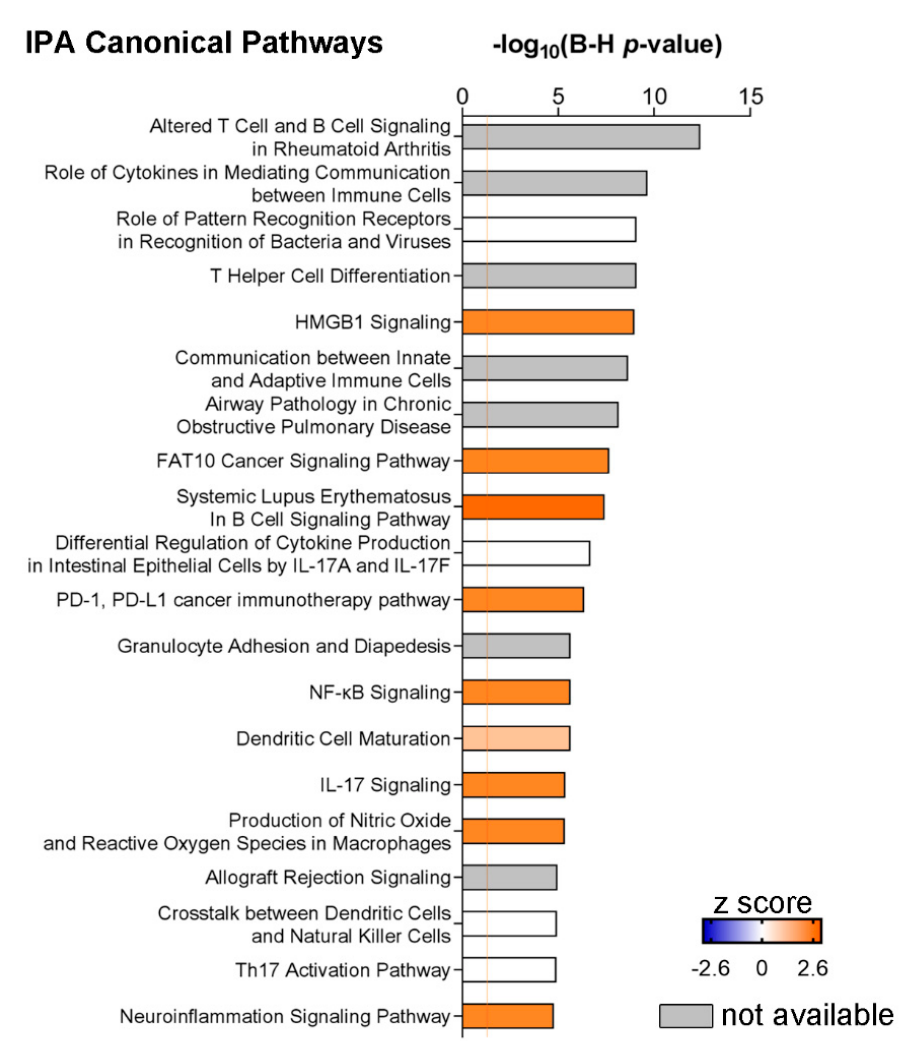
Figure 5. Most significant IPA canonical pathways recognised in the molecular profile of MS-High patients as compared to MS-Low patients. HMGB1 signalling and systemic lupus erythematosus in B cell signalling pathway exhibited a positive z-score, predicting an activation state; other CPs related to T and B cells (altered T cell and B cell signalling in rheumatoid arthritis, role of cytokines in mediating communication between immune cells, T helper cell differentiation and communication between innate and adaptive immune cells) were significantly annotated, without an activation score. Furthermore, other CPs with a significant z-score were PD-1 PD1-L cancer immunotherapy pathway, IL-17 signalling and neuroinflammation signalling pathway. For the complete list of CPs of MS-High profile see Supplementary Table